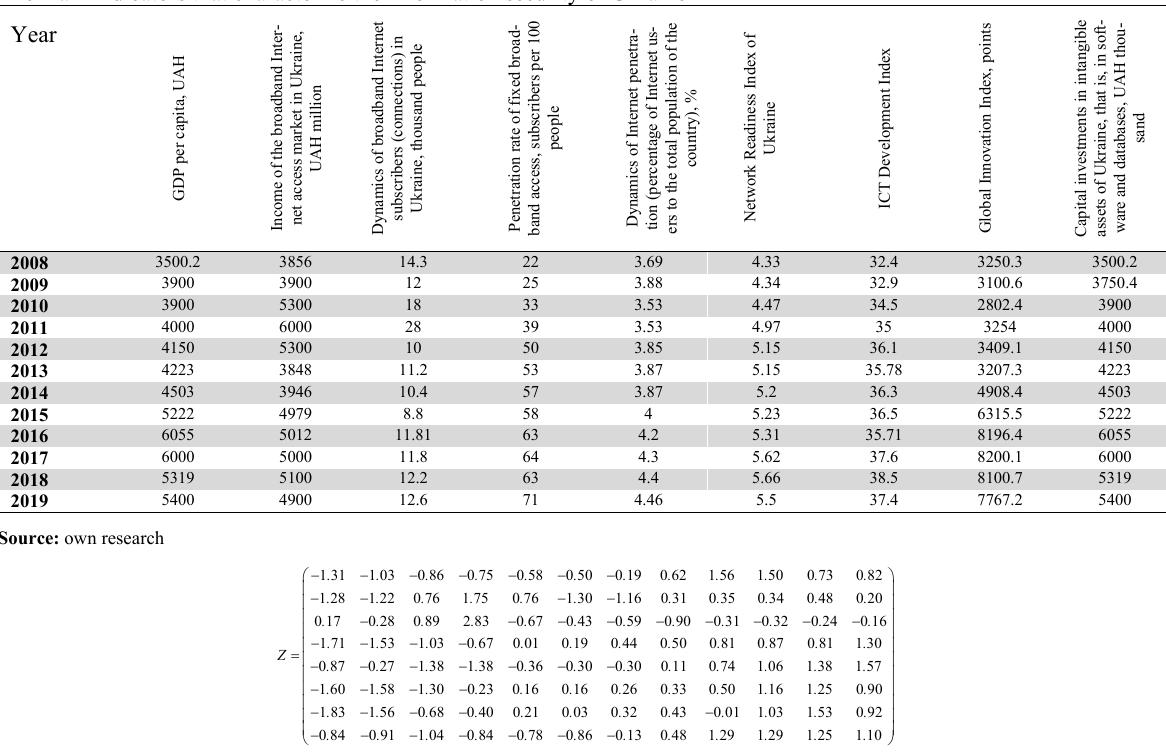
The formation of the ideal vector z ,...,z  was carried out by selecting from the columns of the matrix Z the maximum value for all indicators.